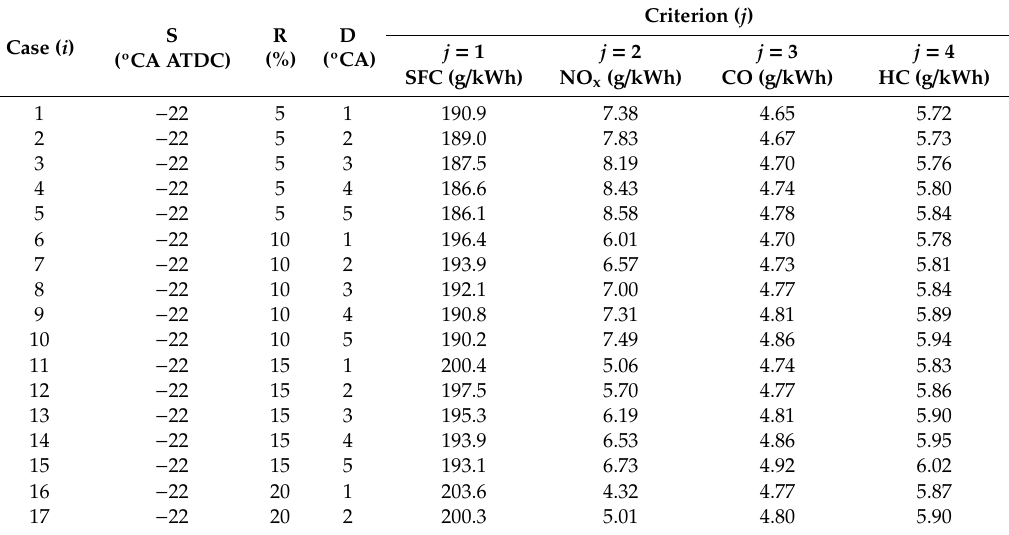
Table 3. Data for the multiple-criteria decision-making (MCDM) problem.